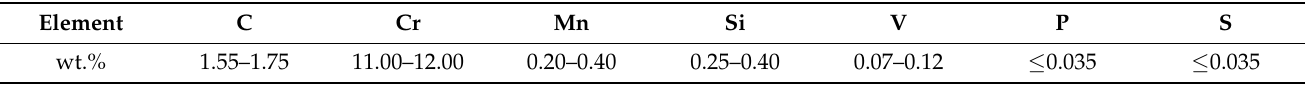
Table 1. Chemical composition of X165CrV12 tool steel used as a substrate material. Element C Cr Mn Si V P S wt.%